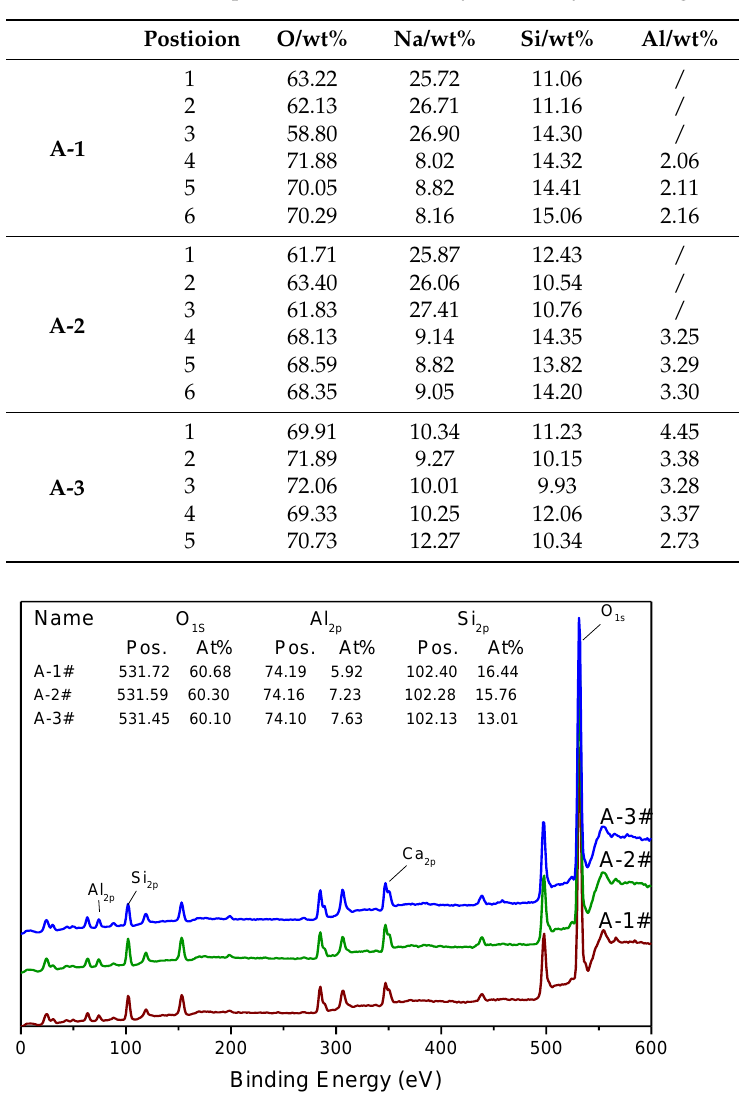
Figure 9. XPS curves of samples with different Ms under the C-1 curing conditions.